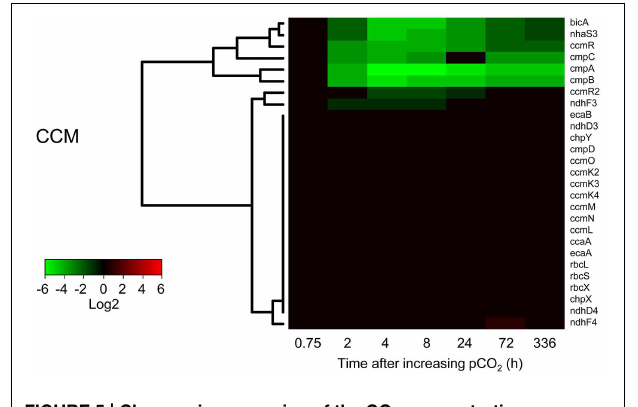
FIGURE 5 | Changes in expression of the CO 2 -concentrating mechanism (CCM) genes after the increase of pCO 2 to 1450ppm. Expression changes are quantified as log2 values. Red indicates significant upregulation and green significant downregulation; non-significant changes are in black. Hierarchical clustering was used to order the genes. The underlying data are presented in Supplementary Table 4.